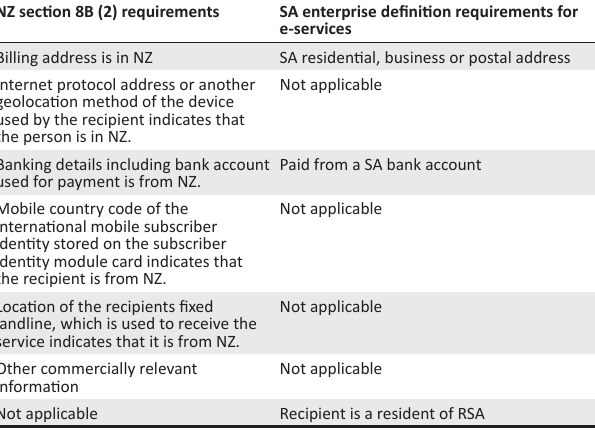
TABLE 1: A comparison of New Zealand’s (NZ’s) requirements to Republic of South Africa’s requirements for taxable supplies of